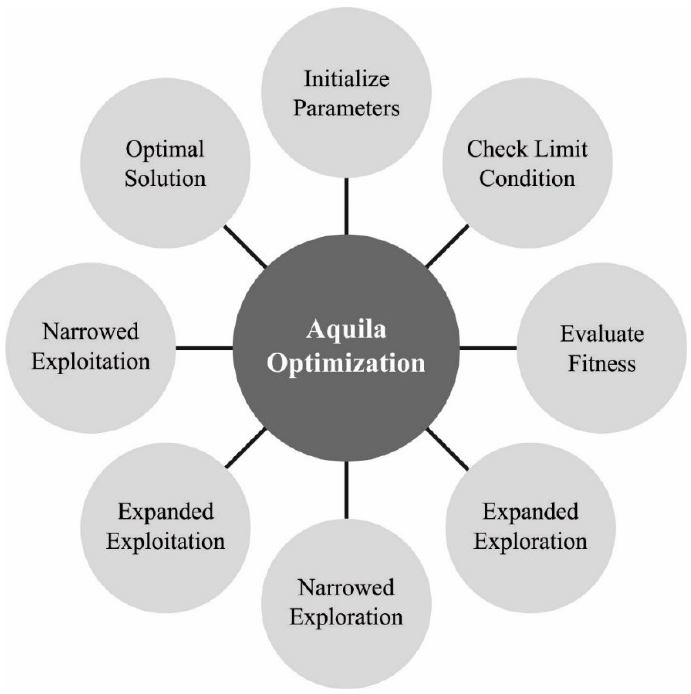
Figure 2. Flowchart of AO.